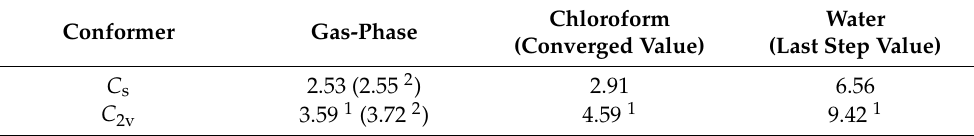
Figure 2. Behavior of the dipole moment of the C s conformer in chloroform during the iterative process. For comparison, the corresponding results for the C 2v conformer (taken from Ref. [16]) are included. Table 2. MP2/aug-cc-pVDZ results for the dipole moment (in a.u.) of the C s conformer in the gas phase and solution. For comparison, the corresponding results for the C s and C 2v conformers are